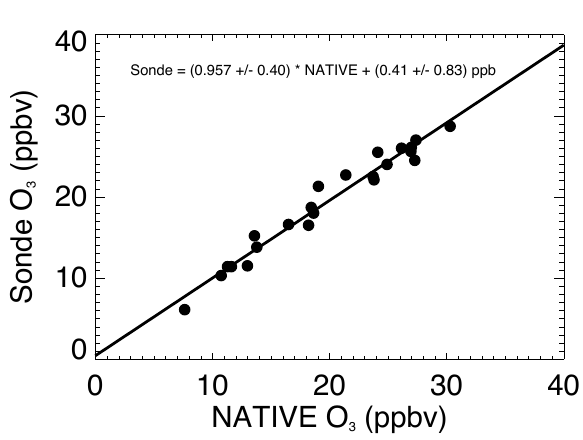
Fig. 1. A comparison between the ozonesonde readings and NA- TIVE surface O 3 measurements at the time of launch. Agreement Figure 1. A comparison between the ozonesonde readings and NATIVE surface O 3 meas-3 is good to within ∼ 5% during the TC-4 urements at the time of launch. Agreement is good to within ~5% during the TC-4 campaign. 4